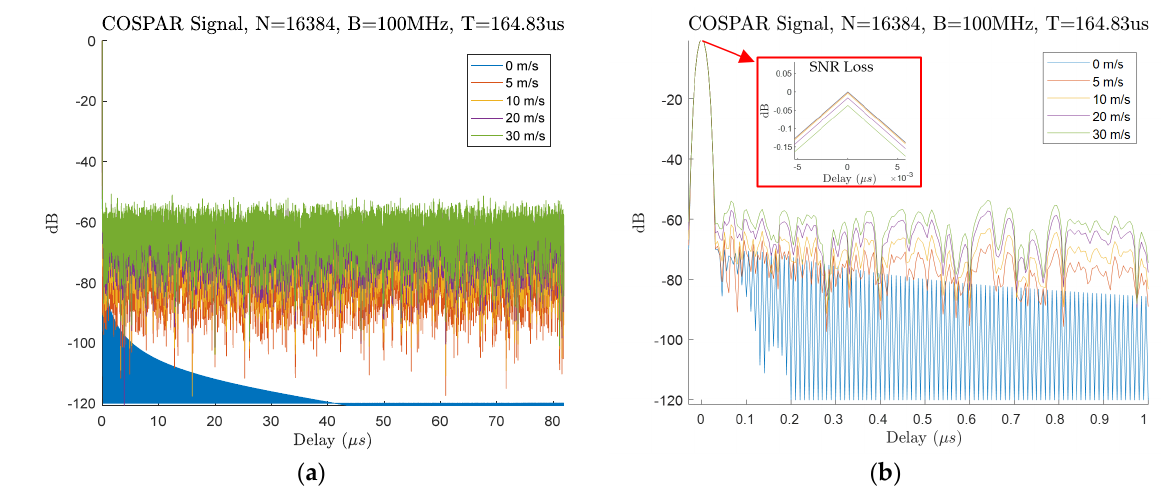
Figure 15. ( a ) Normalized correlation functions under varying Doppler velocities for 0 m/s, 5 m/s, 10 m/s, 20 m/s, 30 m/s. ( b ) Correlation sidelobes adjacent to mainlobe and SNR loss due to Doppler mismatch.